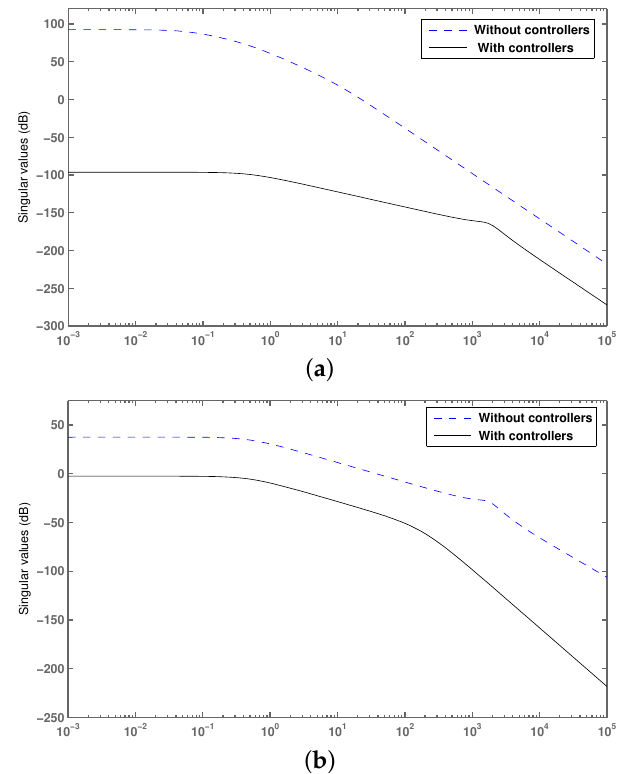
Figure 7. ( a ) Singular value plot of frequency control loop ( ∆ F * → ∆ F ); and ( b ) singular value plot of the supply error control loop ( ∆ P * e → ∆ P e ).